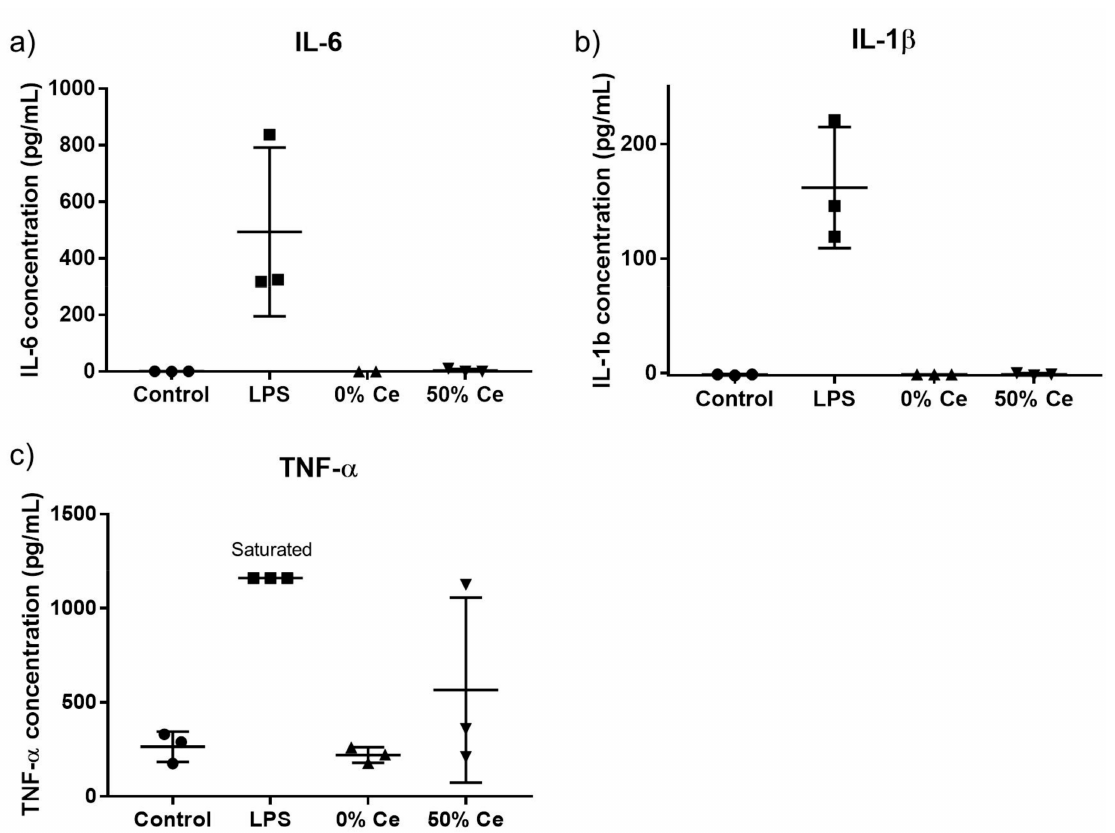
Figure 8. ( a – c ) Pro-inflammatory cytokines IL-6, IL-1 β and TNF- α secretion levels of RAW 264.7 cells treated with 10 µ g/mL of Gd 2 O 2 S (0% Ce) nanoparticles and GdCeO 2 S (50% Ce) nanoparticles during 24 h. Cell treatment with 10 µ g/mL of LPS was used as positive